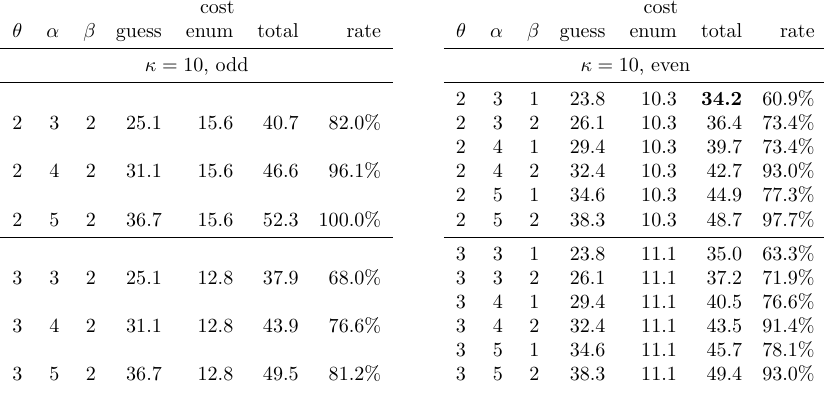
Table 12: Experimental results for New Hope parameters and number of bit-flips κ = 10; θ is the scaling factor of our lattice, α the number of bits we guess in a band of size β . In the “even” case we target the least significant bits of the components of ∆ first. The column “guess” holds the number of guesses before lattice enumeration which includes the cost of guessing ∆ 0 , the column “enum” holds the number of nodes in the pruned lattice-point enumeration tree. The column “total” is the product of the two. All costs are give as log ( · ). The column “rate” is the success rate over 100 experiments. Only 2 parameters with success rate ≥ 50% are shown. The minimal total cost is highlighted in bold and used in Table